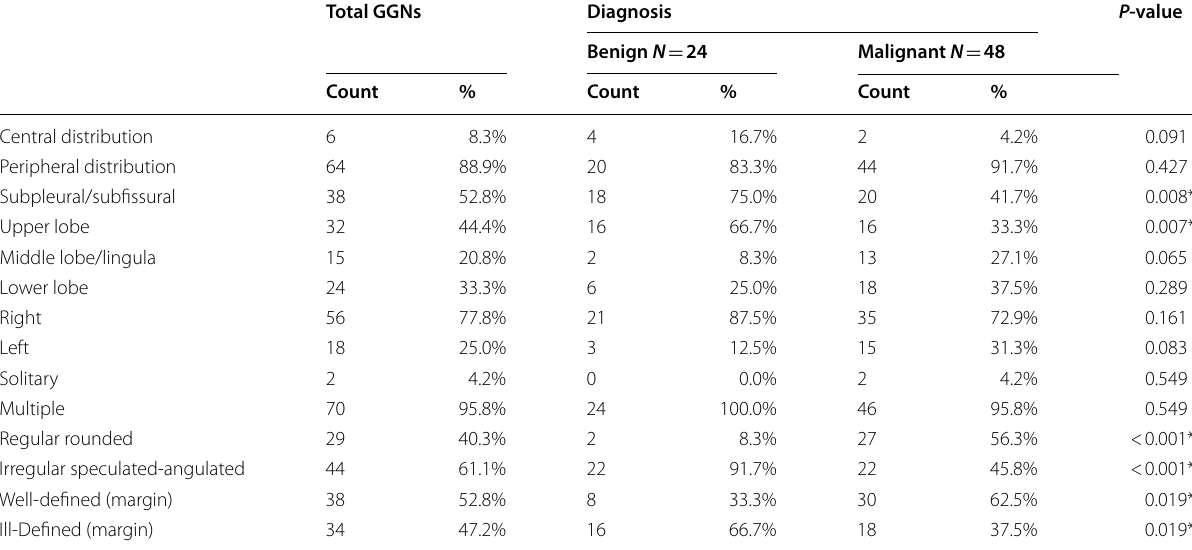
Table 1 Distribution and relation between the neoplastic and non‑neoplastic segmented pGGNs in CT scan regarding their location, shape, and margin